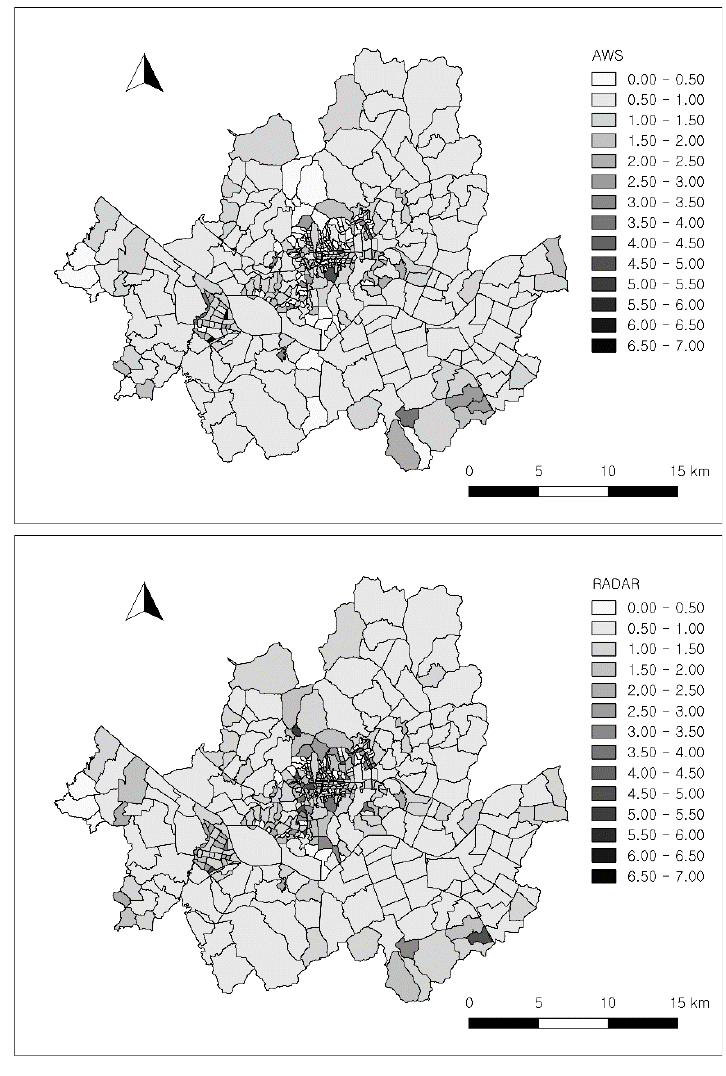
Figure 9. District-wise RAR distribution based on interpolated AWS rainfall (upper) and from radar-derived rainfall (lower) for all accidents in rain conditions.